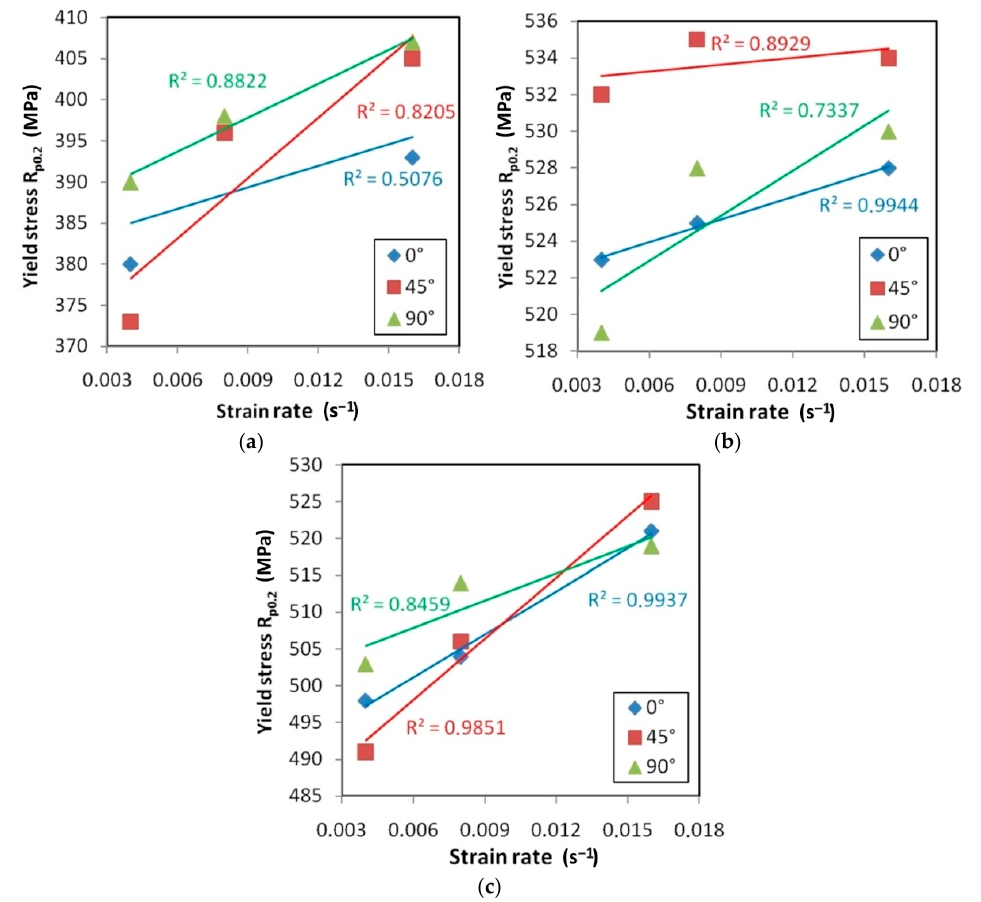
Figure 18. Yield stress vs. strain rate for ( a ) HX, ( b ) I625 and ( c ) I718. The correlations between the variation of the yield stress and measured temperature for the test materials is shown in Figures 19–21.